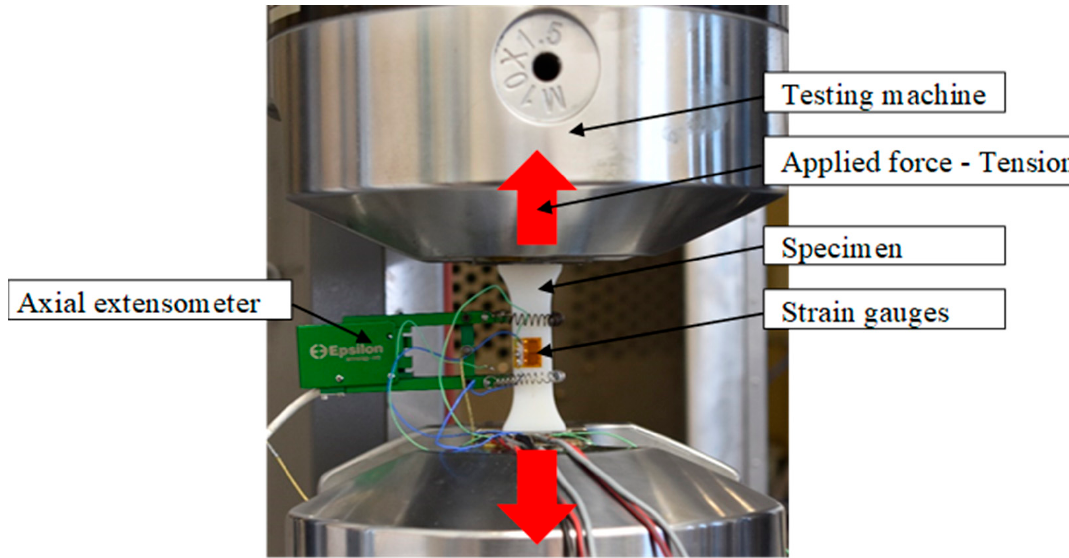
Figure 2. The specimen was mounted in the machine during the tensile test. On the basis of the tests performed, Young’s modulus and Poisson’s ratio, as well as the maximum load and tensile strength, were determined for each specimen. Addition- ally, their average values, standard deviation, and coe ffi cients of variation were calculated for each process. The Young’s modulus from the slope of the strain–stress curve and the data from a strain gauge ranging from 1000–3000 strains were used for the calculations. The stress was calculated in relation to the force and the cross-section of the sample. The width and thickness were measured in the center of the sample. For the calculations, the result is the average of three